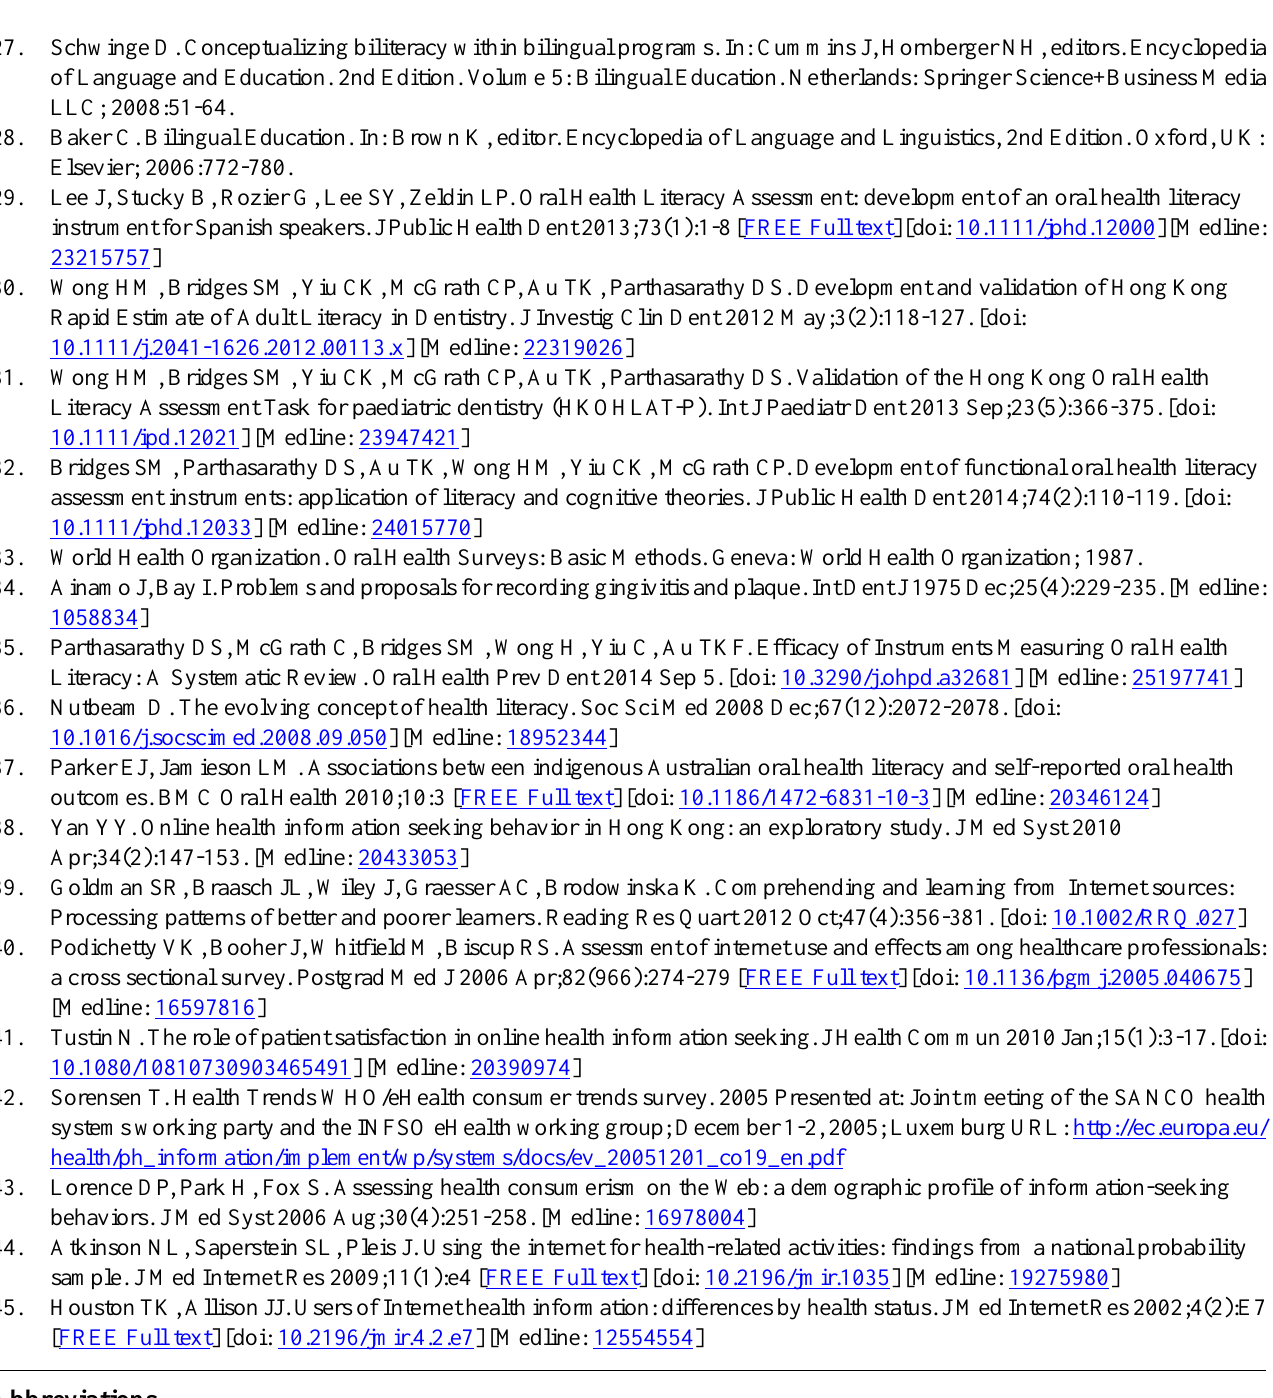
Abbreviations dmft: decayed, missing, filled teeth HKD: Hong Kong